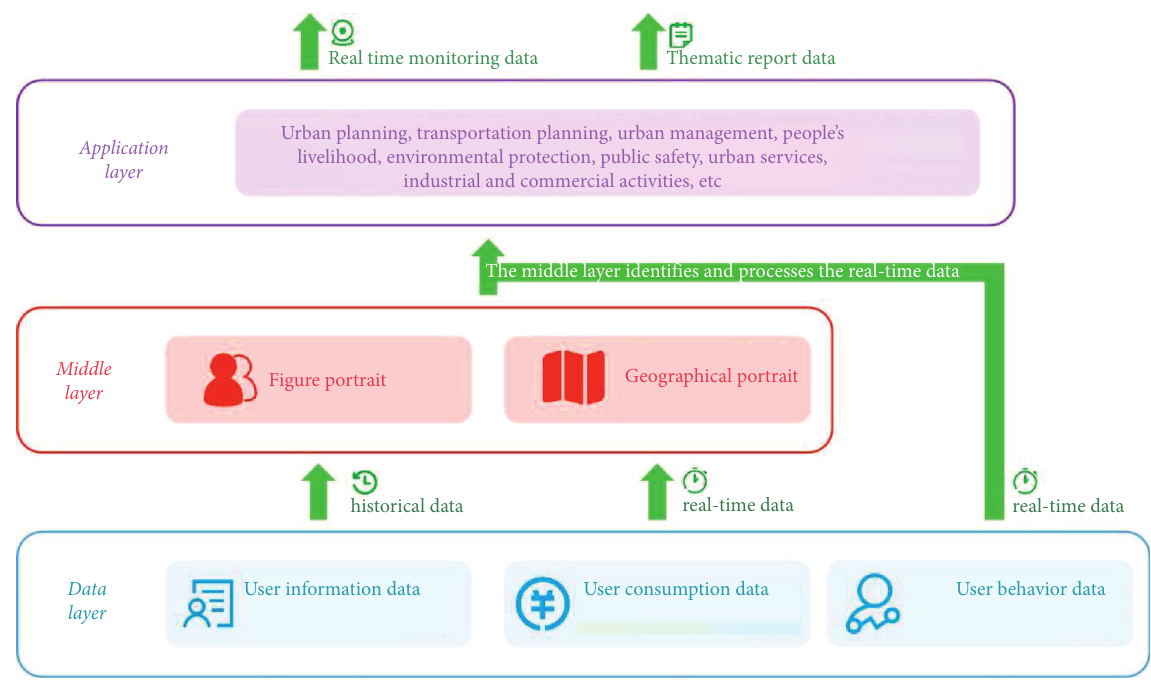
Figure 1: Flowchart of data